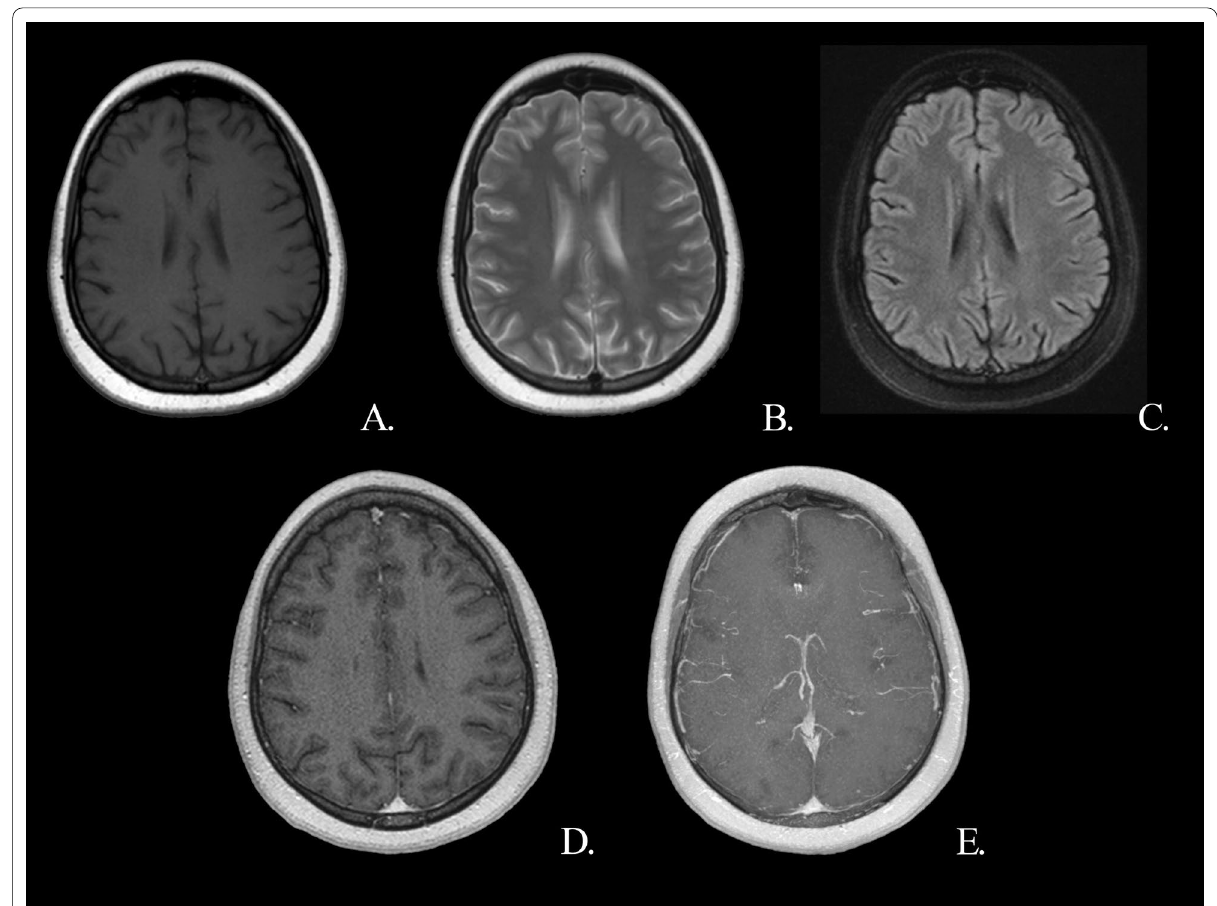
Fig. 2 Control MRI after 2 months of anti-tuberculosis theraphy demonstrates resolution of the lesions. Precontrast T1W axial ( A ), T2W axial ( B ), FLAIR axial ( C ), post-contrast T1W axial ( D ), post-contrast T1W axial MIP images ( E ). FLAIR fluid-attenuated inversion recovery, MIP maximum intensity projection, T1W T1 weighted, T2W T2